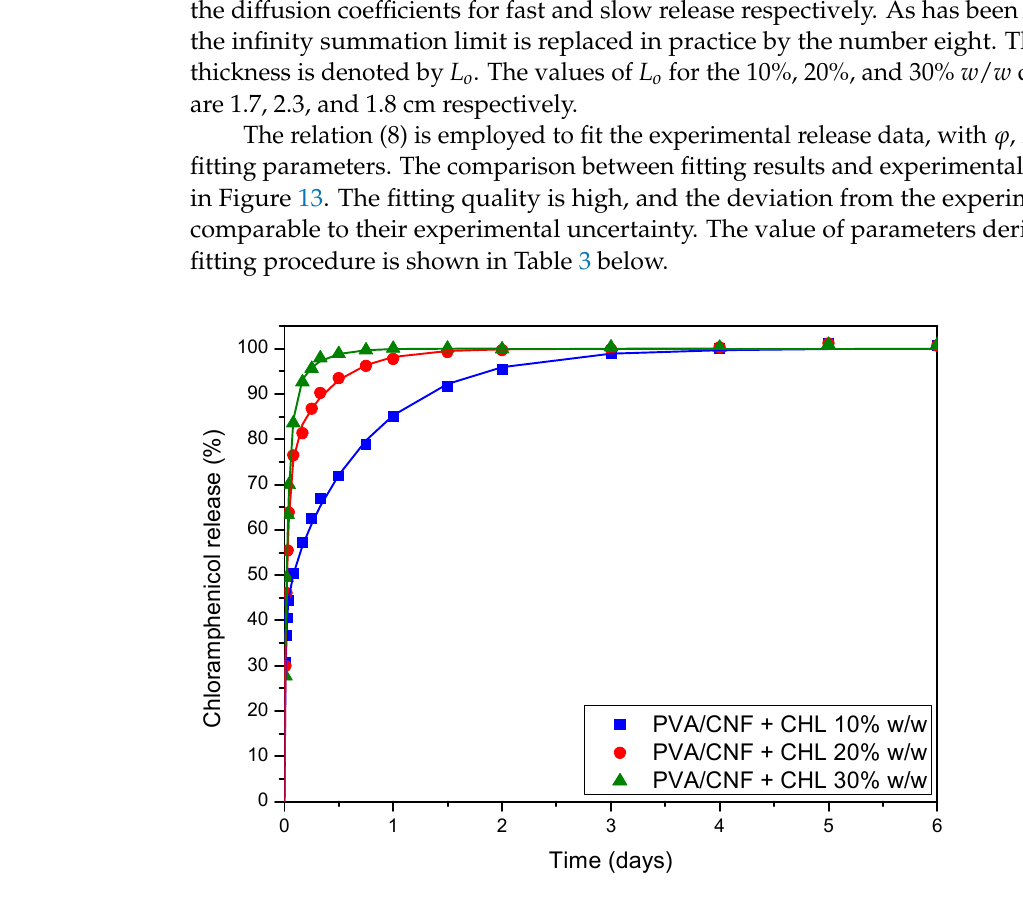
Figure 13. Comparison of experimental release data (symbols) to fitting curves (continuous lines) for the three different loadings of drug. Table 3. Parameters obtained by fitting equation (5) to experimental release data.